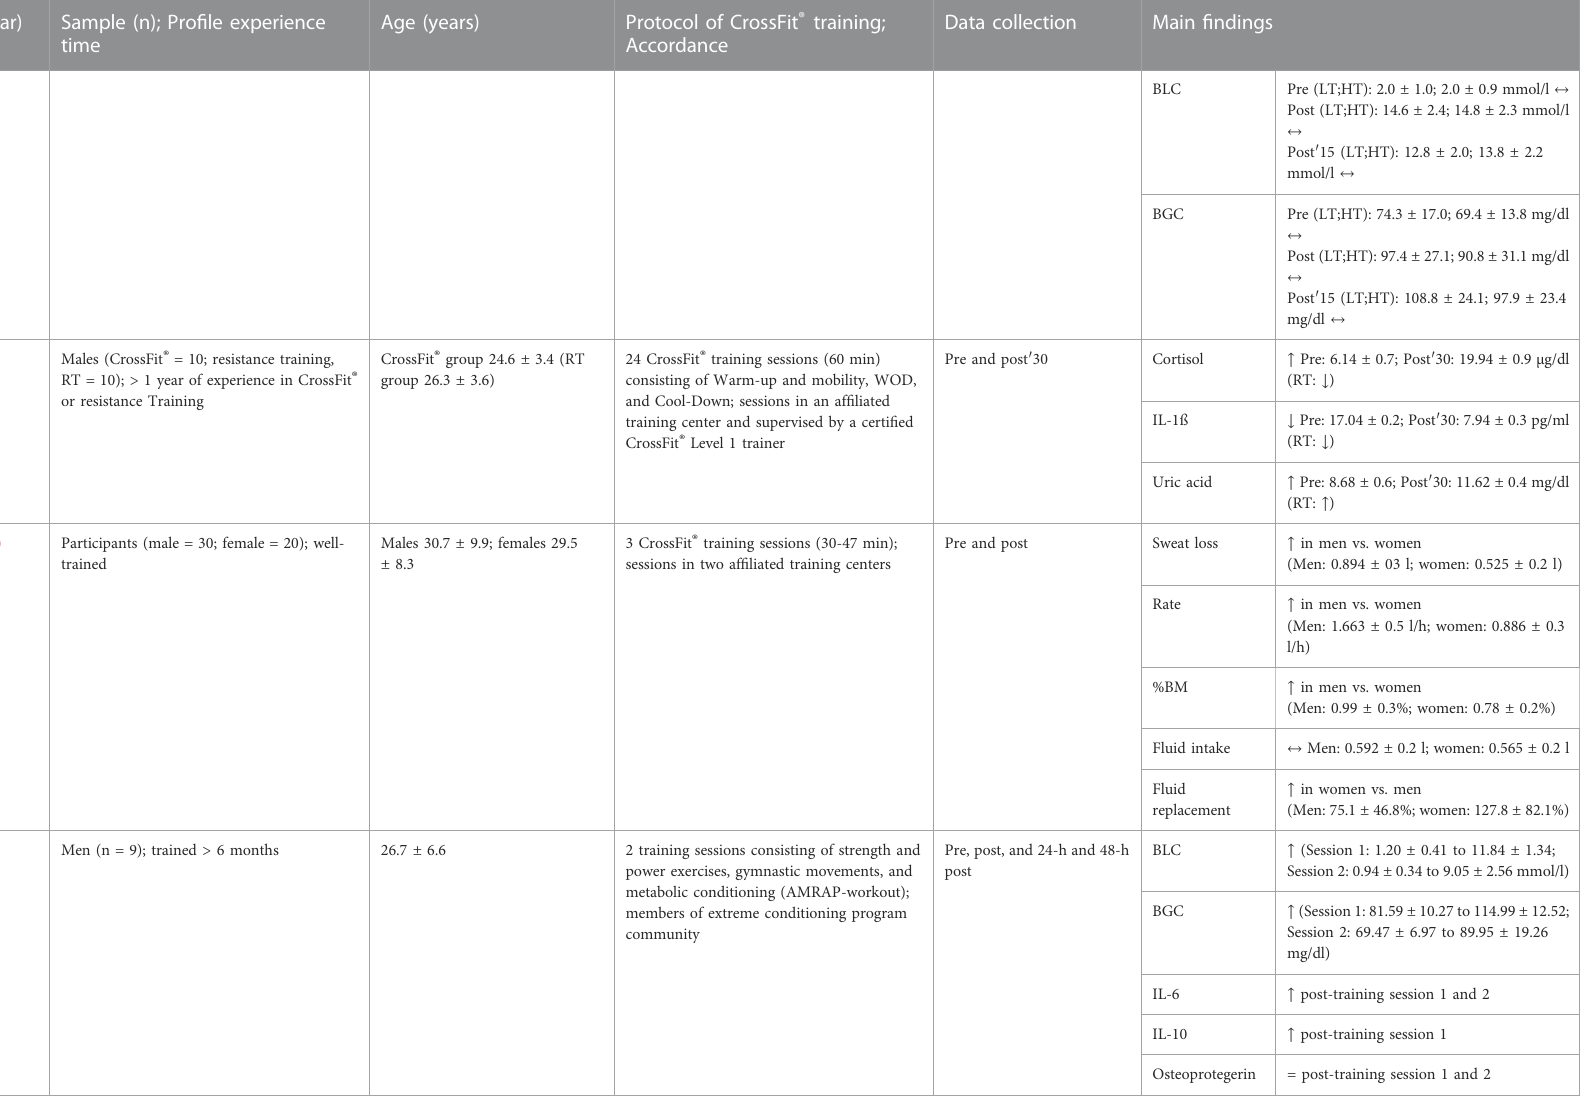
TABLE 2 ( Continued ) Part A: Acute, Short-term Physiological Responses of CrossFit ® training.